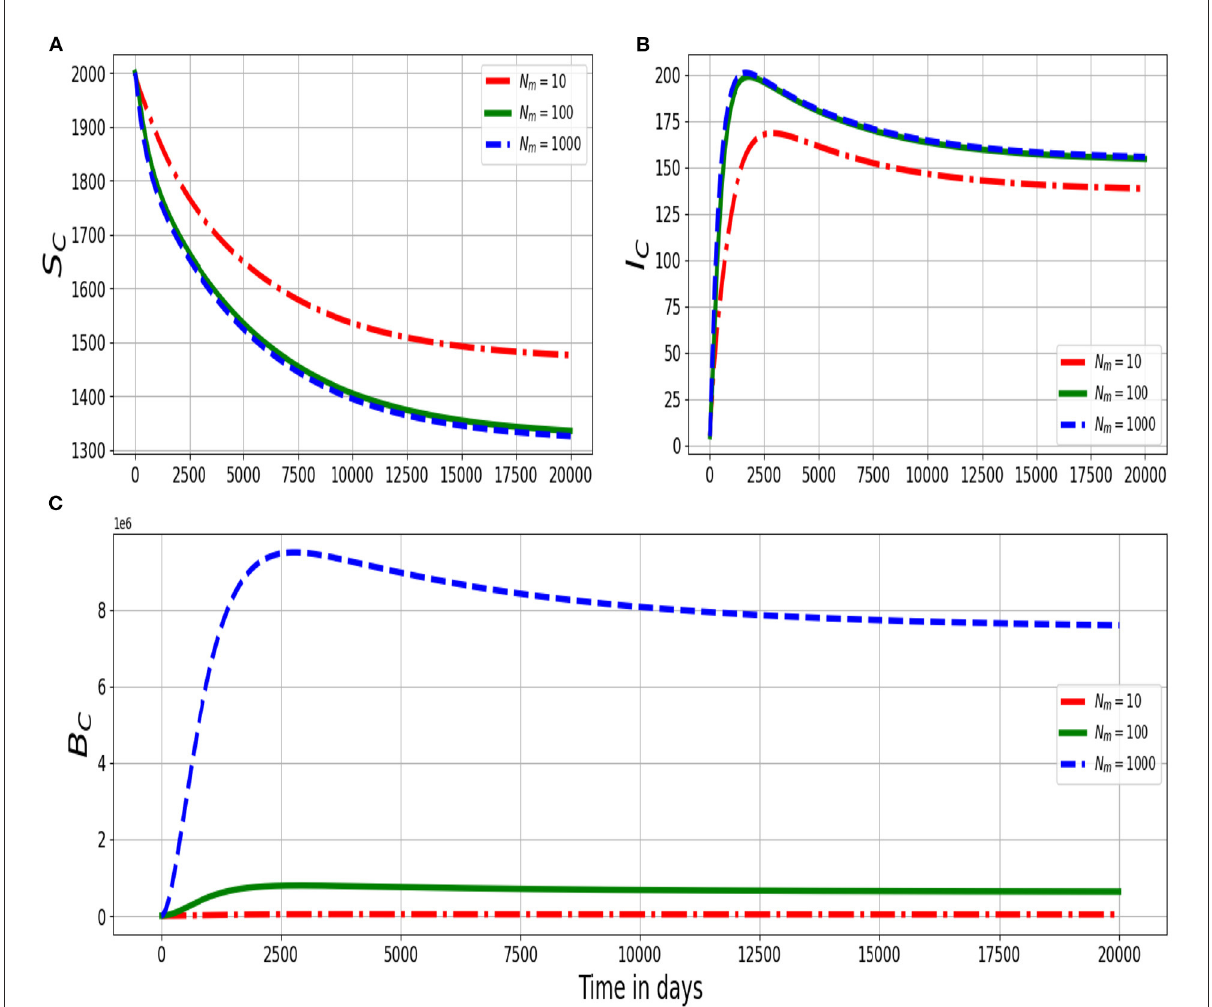
FIGURE5 Graphs of numerical solutions of the multiscale model system (2.4) showing dynamics in (A) population of susceptible ruminants ( S C ), (B) population of infected ruminants ( I C ), and (C) population of environmental MAP bacterial load ( B C ) for different values of within-host scale